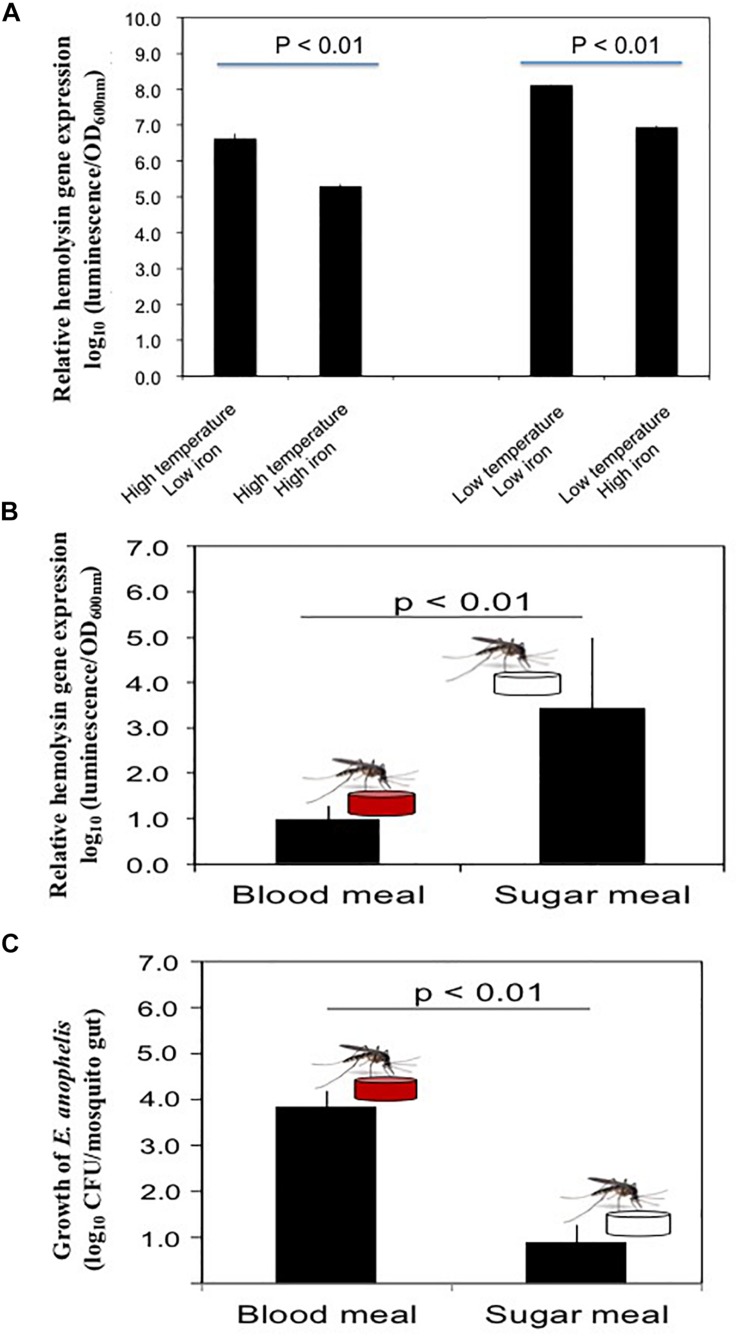
Response of hemolysin genes to temperature, iron stress and diet changes in mosquitoes. (A) Effects of iron and temperature on hemolysin gene expression by E. anophelis in vitro. The high or low temperature was 37 or 22°C, respectively. High-iron medium was established with 12 μM of iron (final concentration), while the low iron medium was established with 200 mM of 2,2-dipyridyl (final concentration). Values are means ± standard deviation. (B) Comparison of hemolysin gene expression in E. anophelis when mosquitoes were fed sugar and blood meals. A. stephensi were fed with 10% sucrose supplemented with E. anophelis for 24 h (NanoLuc reporter strain). For blood meals, mosquitoes were fed bovine blood through a membrane. Values are means ± standard deviation. (C) Density of E. anophelis in mosquitoes given a blood meal or sugar meal. Cell growth was expressed relative to that measured with sugar meal as 100%. Values are means ± standard deviation. Differences were significant at P < 0.05.